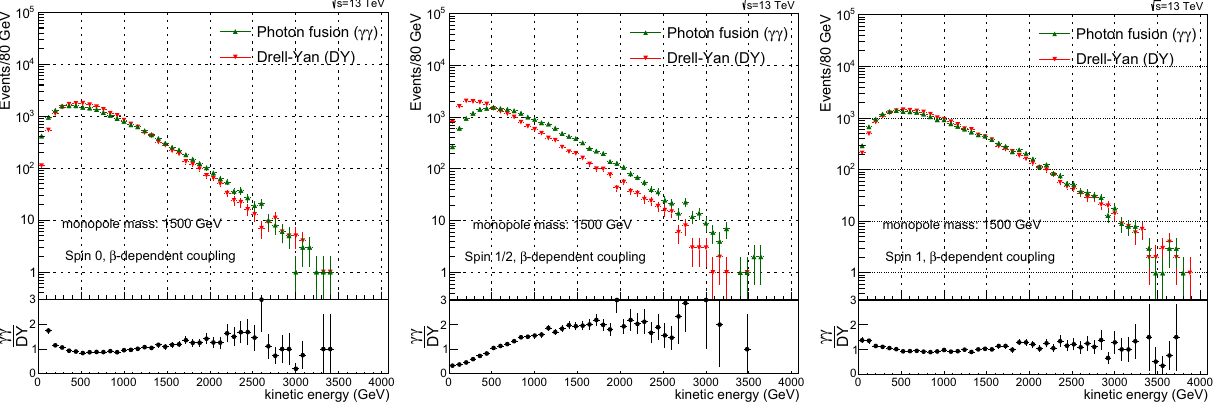
Fig. 23 The monopole kinetic energy distributions of spin-0 (left), spin- 1 / 2 (centre) and spin-1 monopoles (right) for both the photon-fusion and the √ s = 13 TeV and for ˜ κ = 0. The LUXqed and NNPDF23 PDFs were used for the PF and the DY process, Drell–Yan mechanisms at